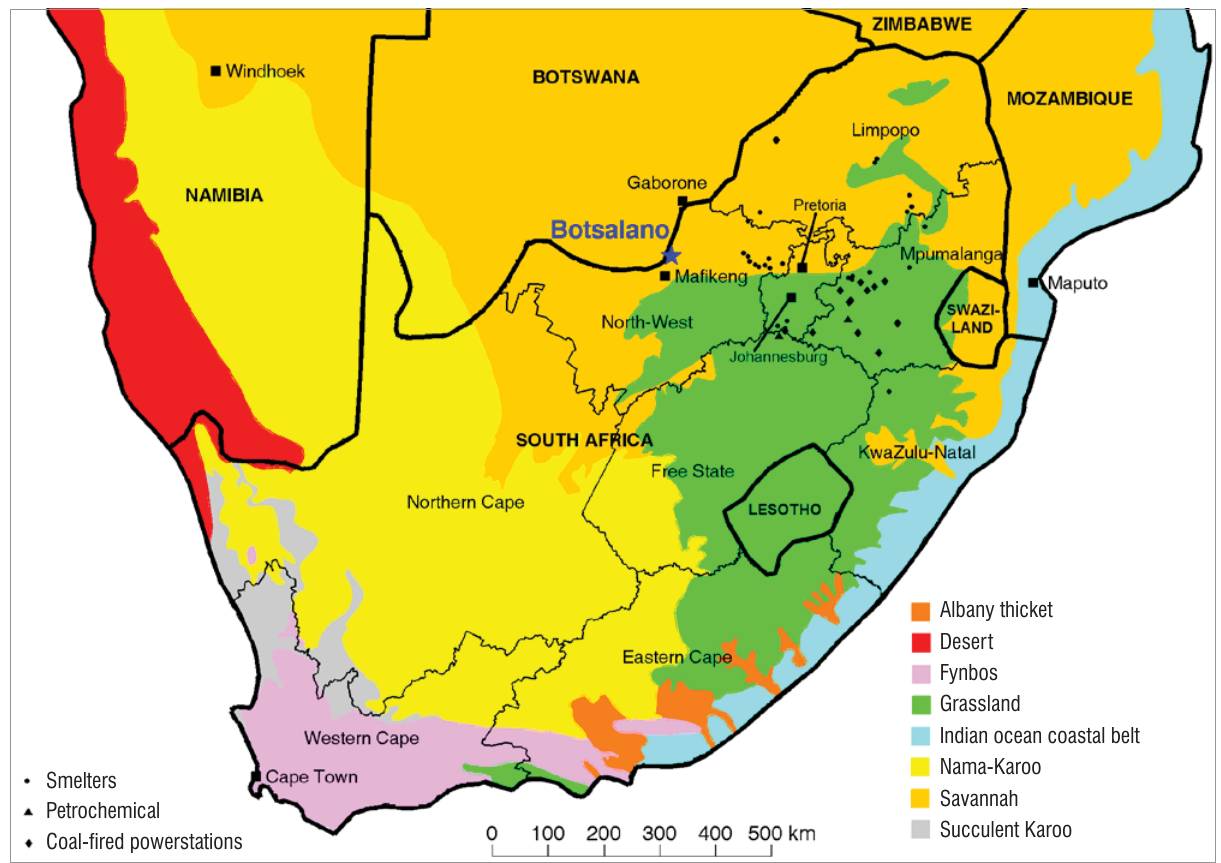
Figure 1: Location of the Botsalano measurement site in South Africa within a regional context. The nearest city, Mafikeng, as well as Johannesburg, Pretoria and Cape Town are shown. All major atmospheric point sources within an approximately 500-km radius around Botsalano and the biomes in southern Africa are also